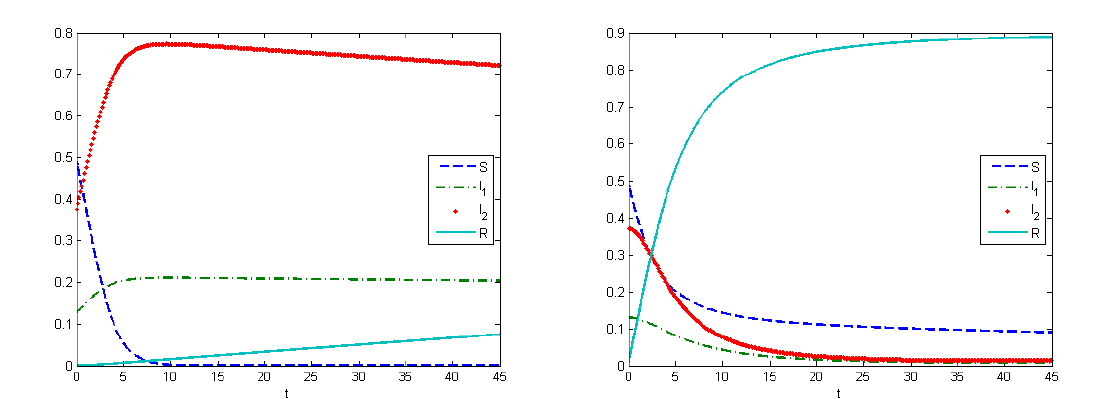
Figure 4. Experiment 2. Left : SIR model with virus mutation and without applying control. Maximum values are I 1 max = 0.2165, I 2 max = 0.7746. Epidemic peaks reached at the 11th and 8th days. Right : SIR model with virus mutation and application of control. Functions h i ( u i ) were convex. Vertical axes show the fractions of the subpopulations.